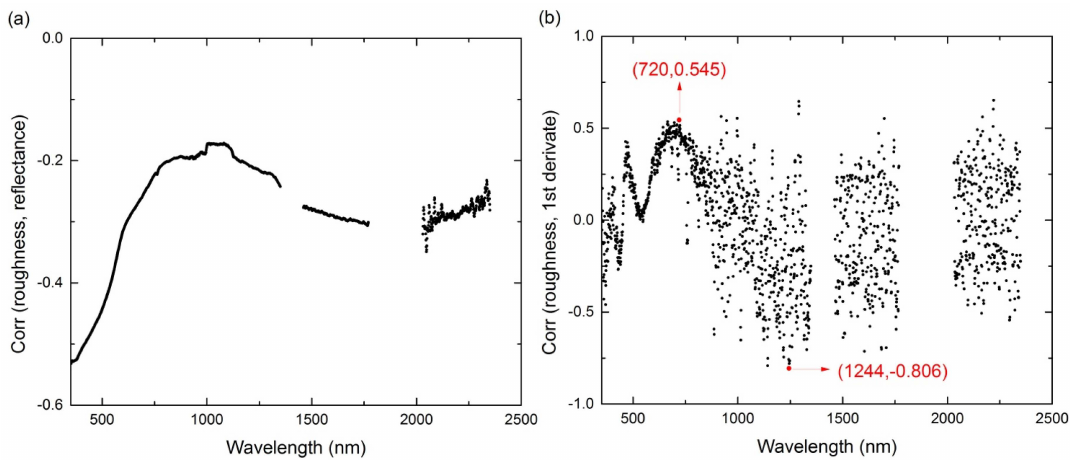
Figure 8. ( a ) Correlation between surface roughness and reflectance at each wavelength; ( b ) Correlation between surface roughness and the first derivate of reflectance at each